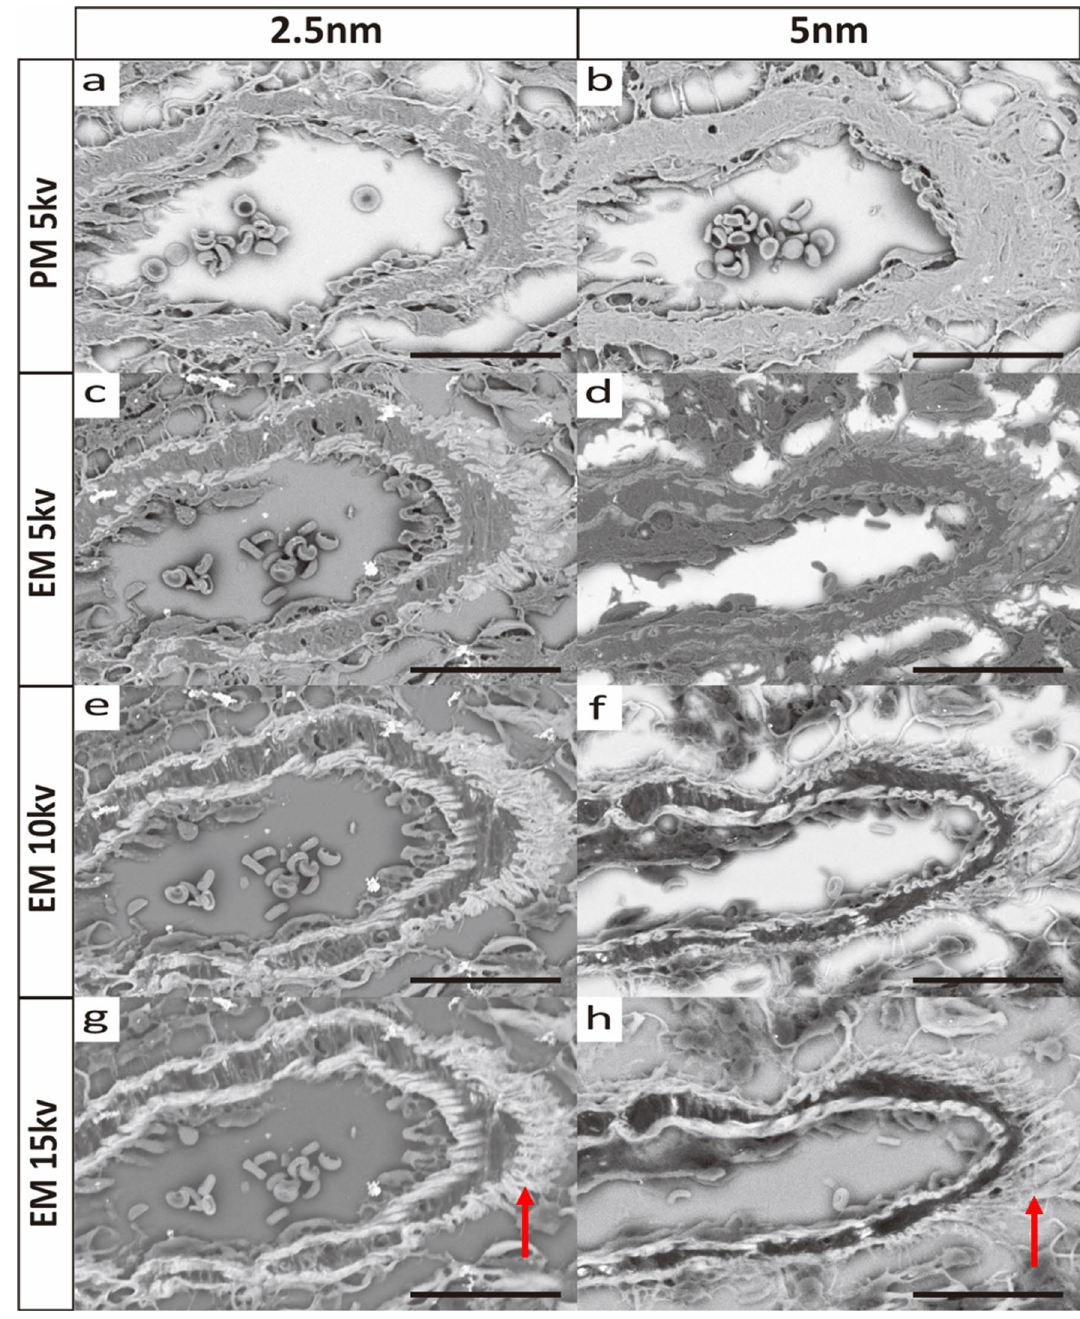
Figure 1. SEM images of Grocott-stained paraffin specimens of bronchial companion artery (Ar) resected from wild-type mice without any treatment. ( a )–( h ) indicates the same area. ( a ), ( b ) PM, 5kv, coating thickness 2.5 nm and 5.0 nm. ( c ), ( d ) EM, 5kv, coating 2.5 nm and 5.0 nm. ( e ), ( f ) EM, 10kv, coating 2.5 nm and 5.0 nm. ( g ), ( h ) EM, 15kv, coating 2.5 nm and 5.0 nm. ( a , b ) For PM, 5kv, 5.0 nm, image was uniform and difficult to observe the microstructure, while 2.5 nm provided contrast. ( a , c ) The same 5kv, 2.5 nm coating provided images with higher contrast in EM than in PM. ( b , d ) In both PM and EM, the 5kv, 5.0 nm coating provided images with higher contrast. In both PM and EM, 5kv, 5.0 nm coating did not depict microstructure. ( e , f ) EM, 10kv, gave clear images, but 2.5 nm gave better contrast. ( g , h ) EM, 15kv showed image disturbance due to charge-up (arrows). All scale bars show 25 μm